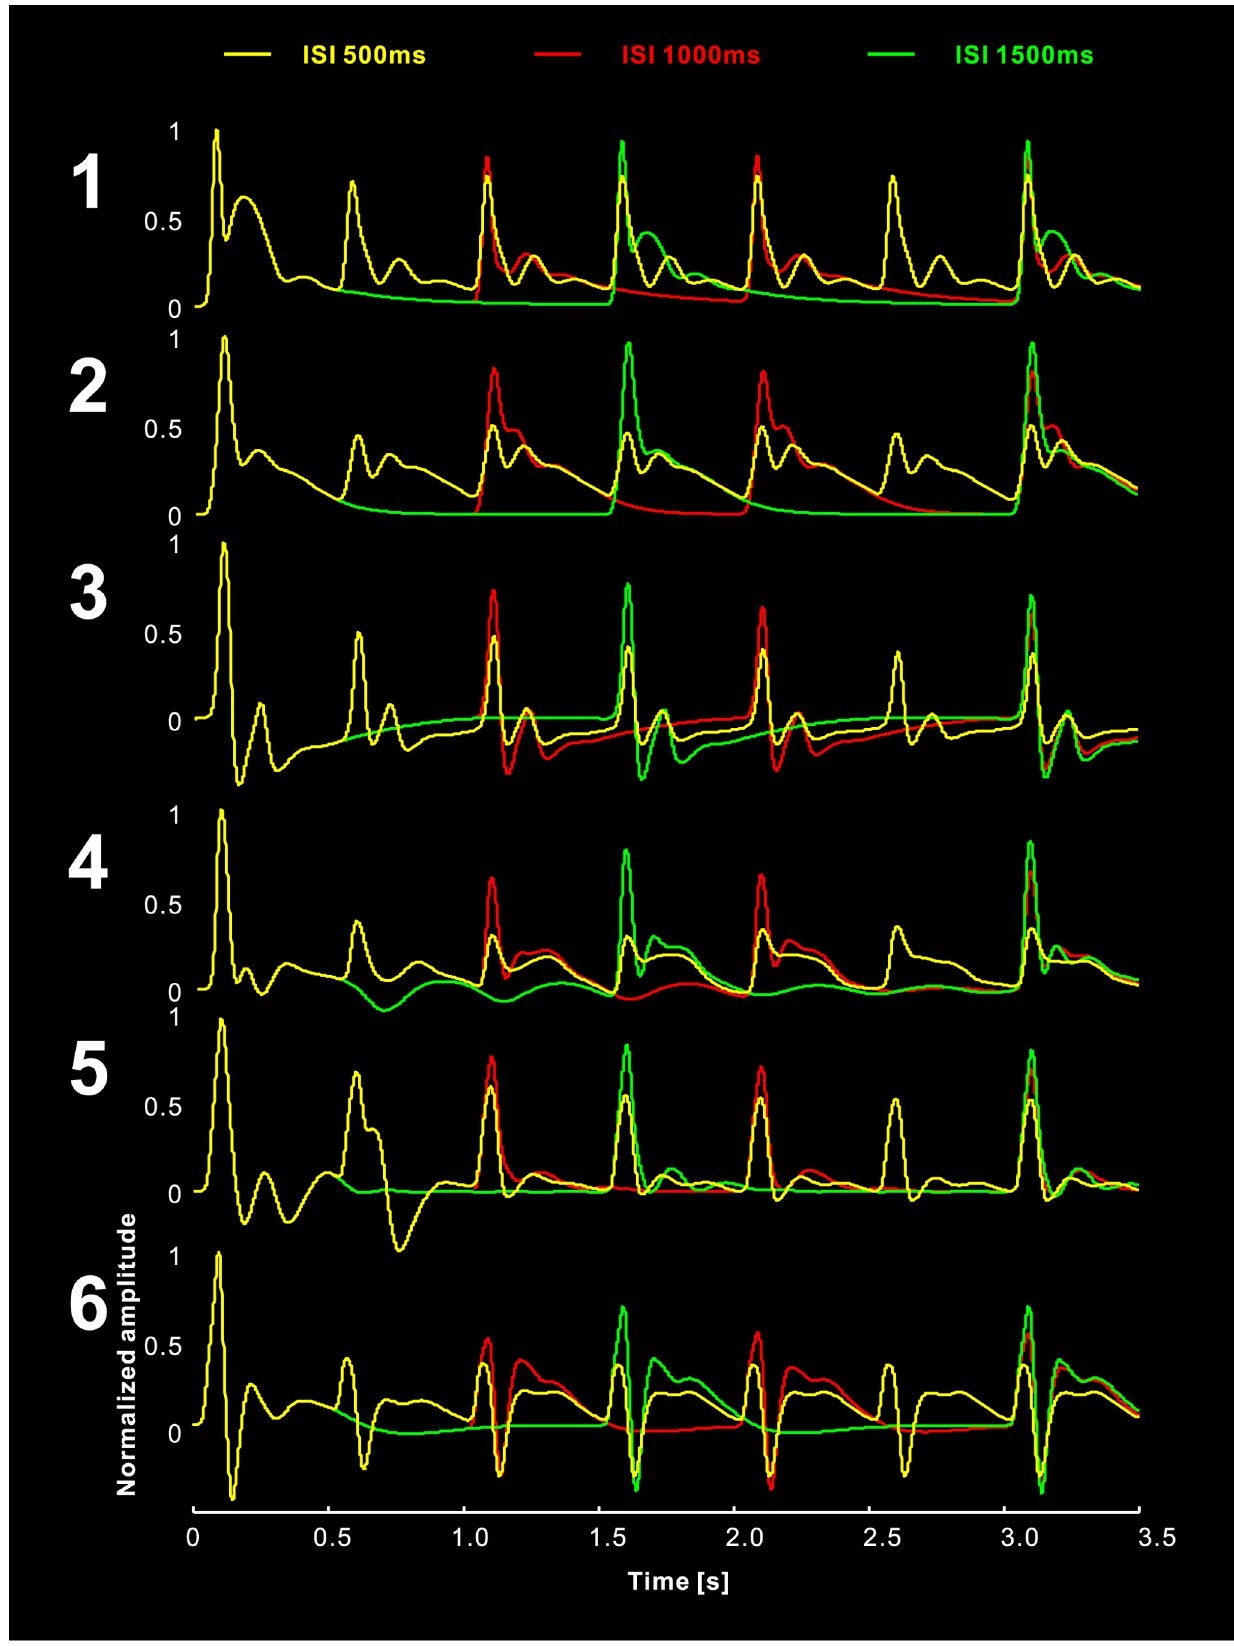
Figure 9. Simulated data using variable inter-stimuli interval (ISI) (500 ms, 1000 ms, and 1500 ms). doi:10.1371/journal.pone.0077876.g009 PLOS ONE |